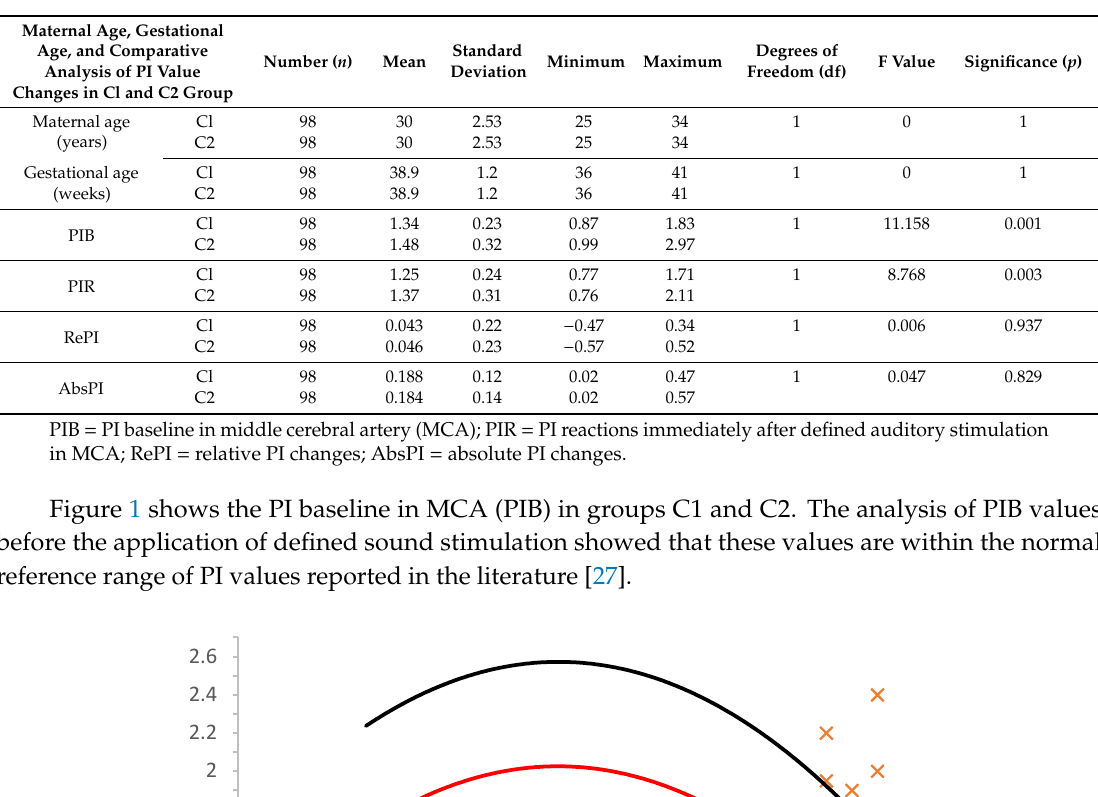
Table 1. Comparative analysis of maternal age, gestation week, absolute PI (AbsPI) changes, and relative PI (RePI) changes in groups C1 and C2.